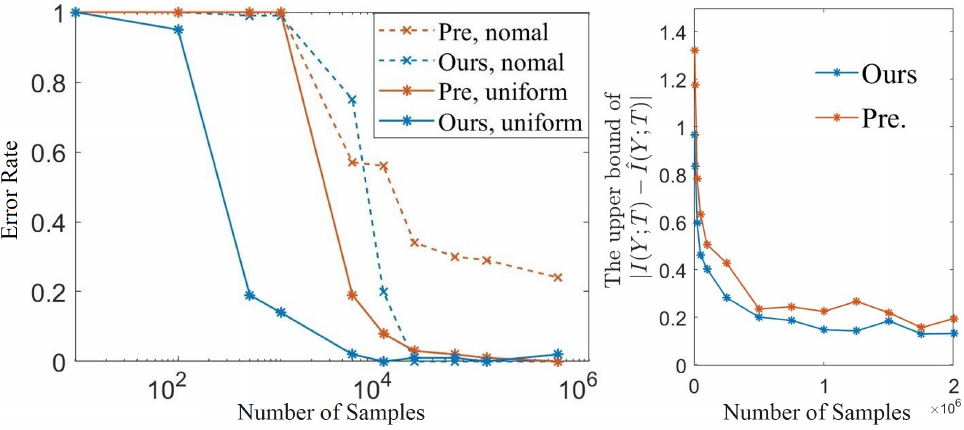
Figure 3. Pre. denotes the previous bound. Left: Comparisons of the two bounds with respect to the constraint error as the sample size grows. Right: Comparisons of the two bounds with respect to the tightness when samples are sufficient.